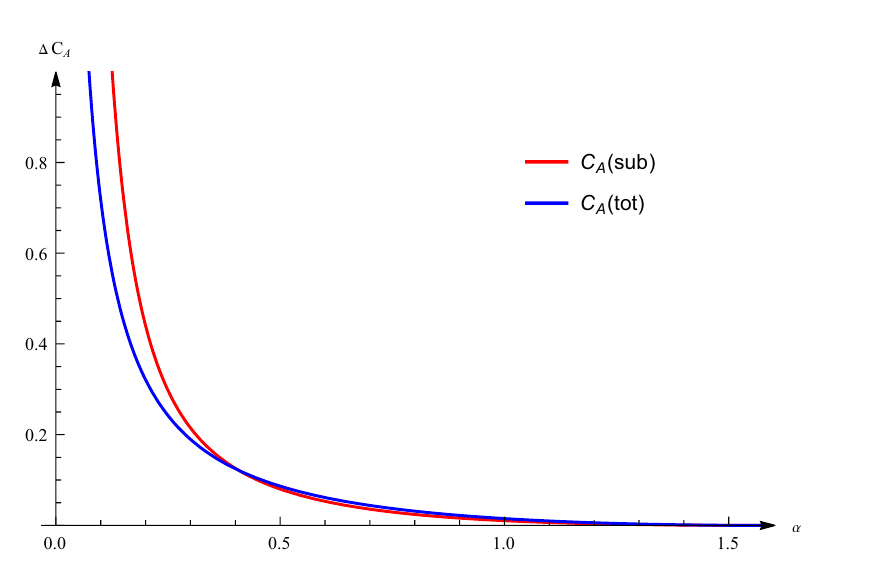
Figure 8 . Plot of the contribution of the defect to the subregion complexity in eq. (4.39) as a function of α (red) and comparison with the result for the total space studied in [65] (blue). Here we set L/G = 1